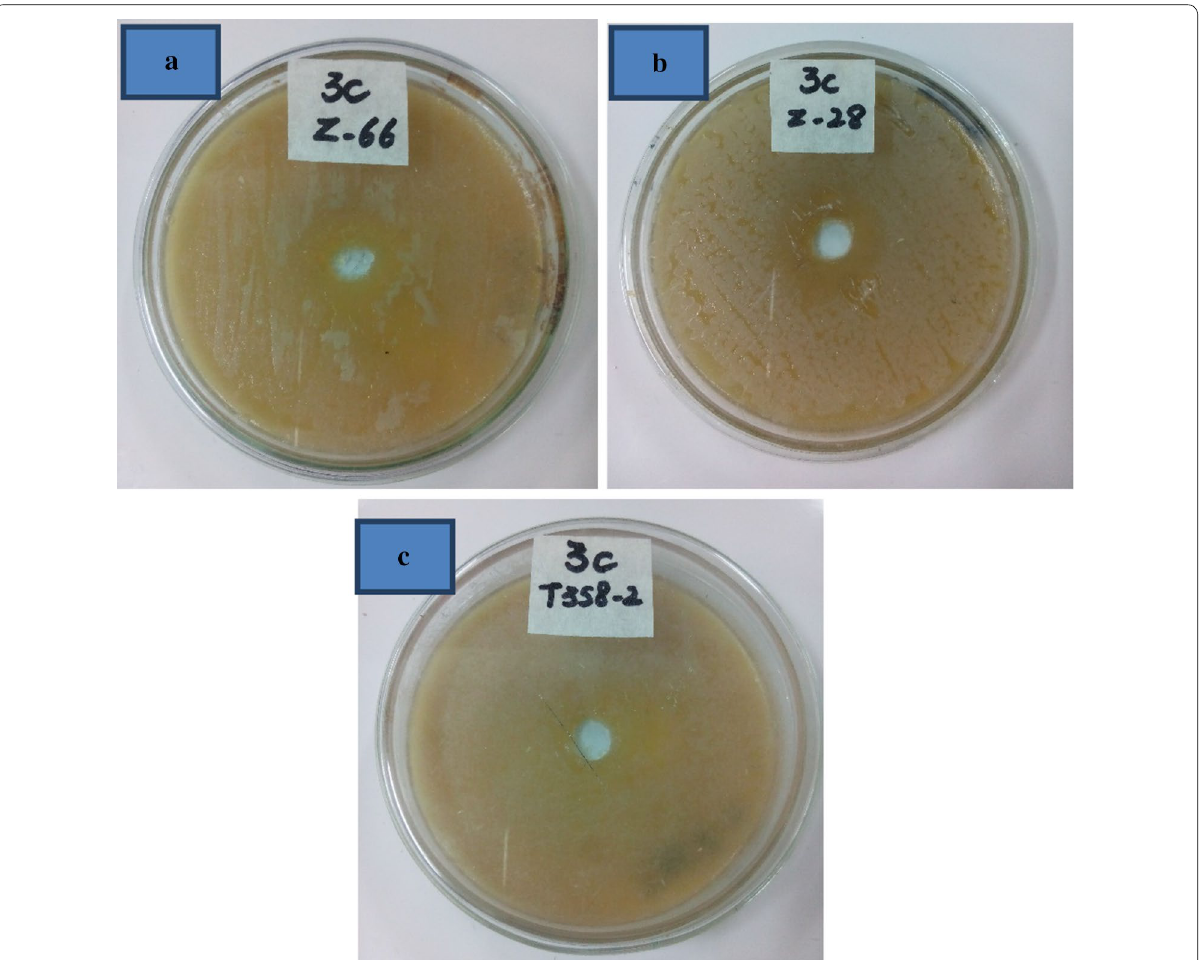
Fig. 7 Bacterial decolorized broth used for incubation of a B. subtilis (z-66), b B. megatarium (z-28) and c B. cereus (T358-2) at 37 °C for 48 h. No zone of inhibition was observed in any